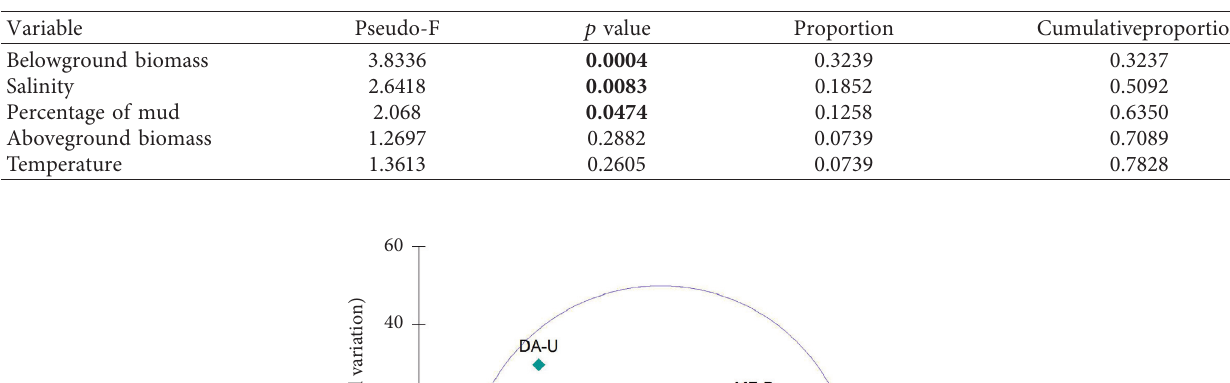
Figure 3: Principal coordinate analysis (PCO) of benthic fauna mean abundance data of sampled sites. Attributes that were most associated to the PCO axes (Person correlations > 0.3) are represented by vectors that overlap the PCO. Table 8: Results of the sequential test of the multivariate regression analysis (DistLM). Environmental variables were analyzed individually (marginal test) and sequentially using a forward selection procedure (adjusted R 2 � an information criterion).